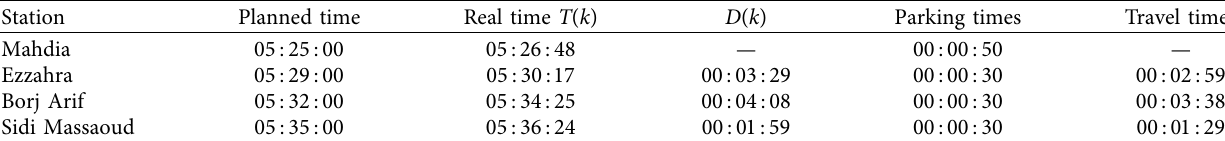
Table 3: Parking and travelling times between Mahdia and Sidi Massaoud stations.